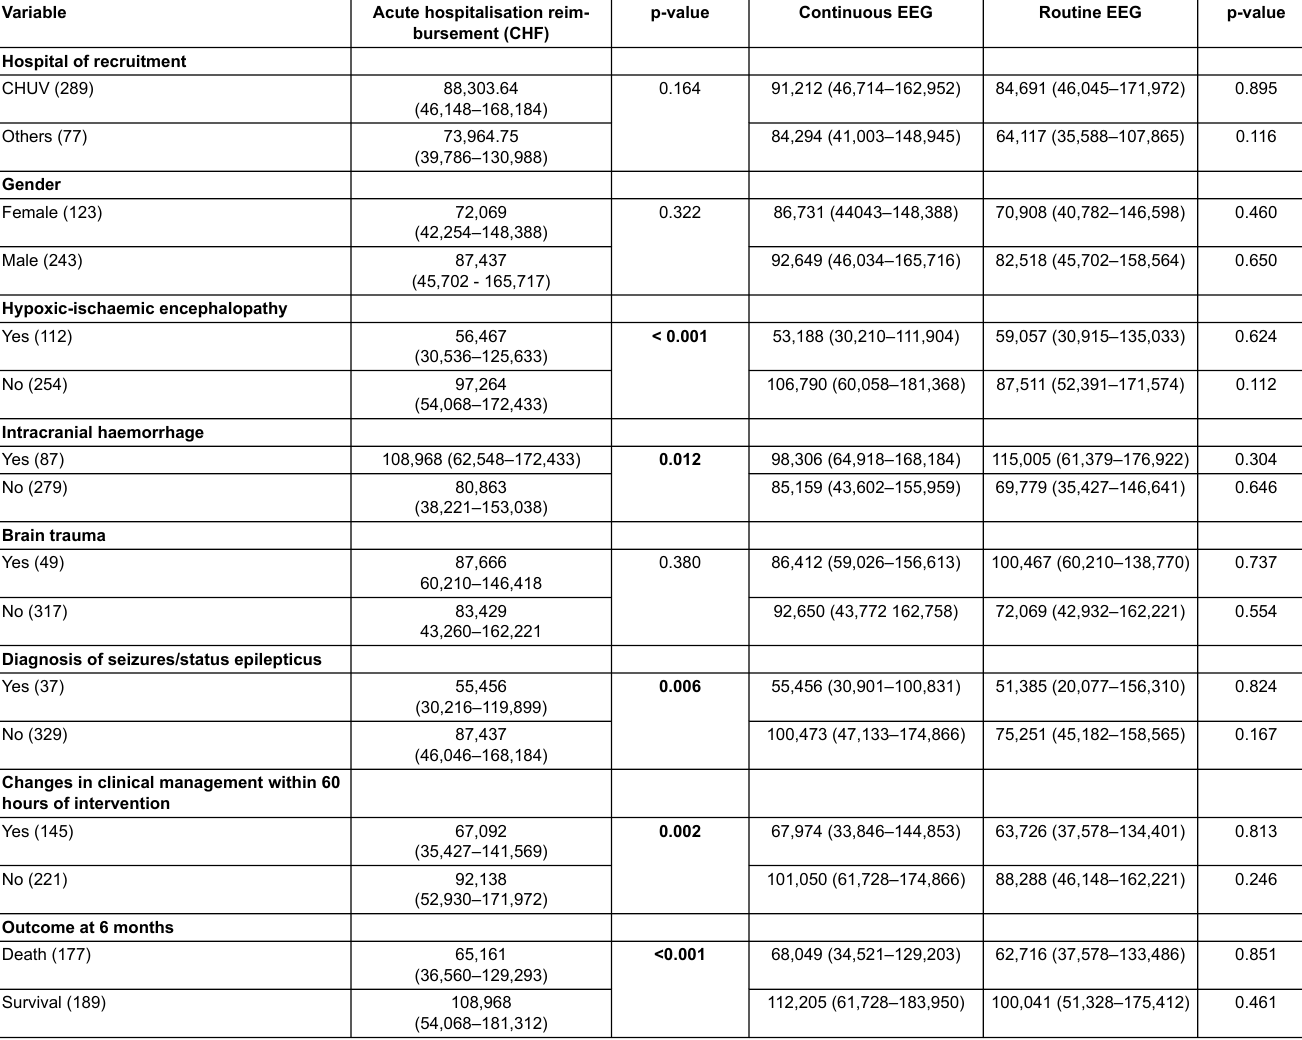
Table 1: Reimbursement and variables of interests (for the whole cohort, and stratified by EEG intervention group). Numbers represent medians (and interquartile range). Bold numbers are significant (Mann-Whitney U-tests).